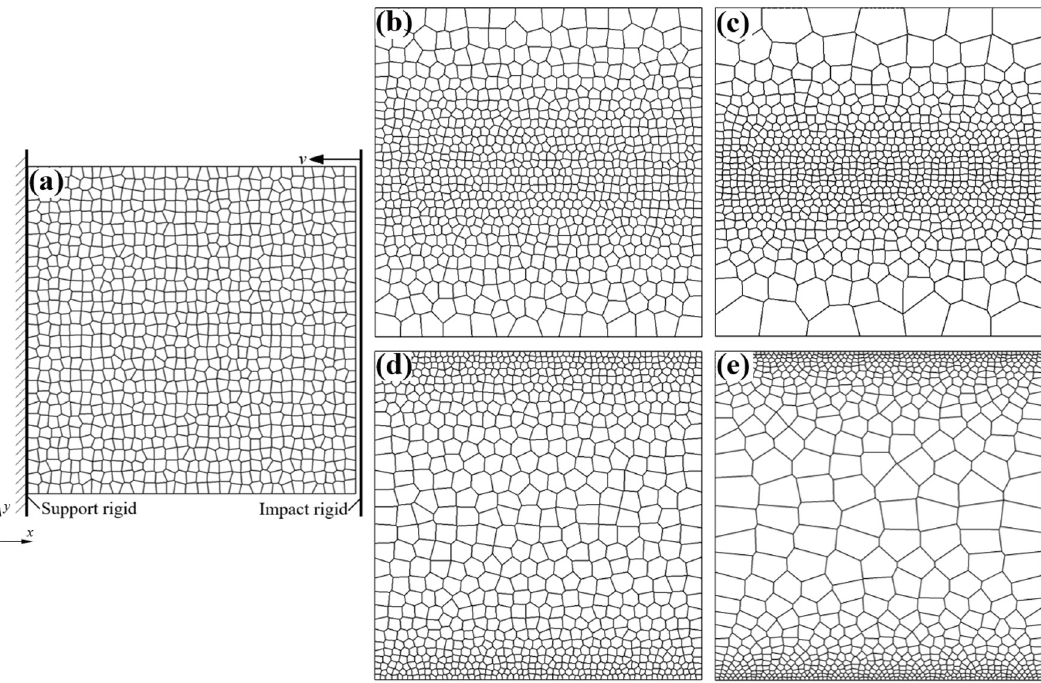
Figure 3: Voronoi models and the schematic diagram of uniaxial impact compression. Gradient coe ffi cient a = ( a ) 0, ( b ) 0.25, ( c ) 0.35, ( d ) − 0.4, and ( e ) −